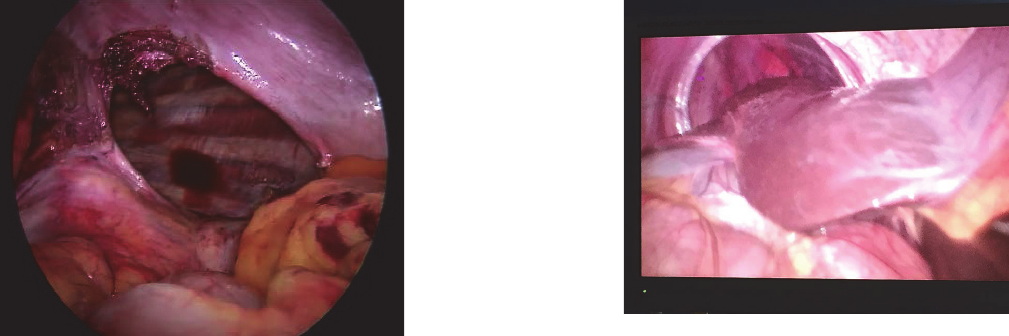
Figure 3: Right-sided eventration of diaphragm content as liver protuberance.